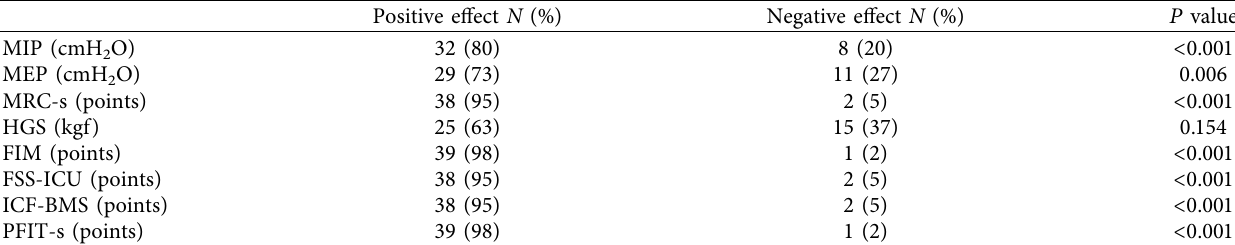
Table 3: Binomial analysis between the frequencies of the positive and negative effects of respiratory and peripheral muscle strength and functionality.